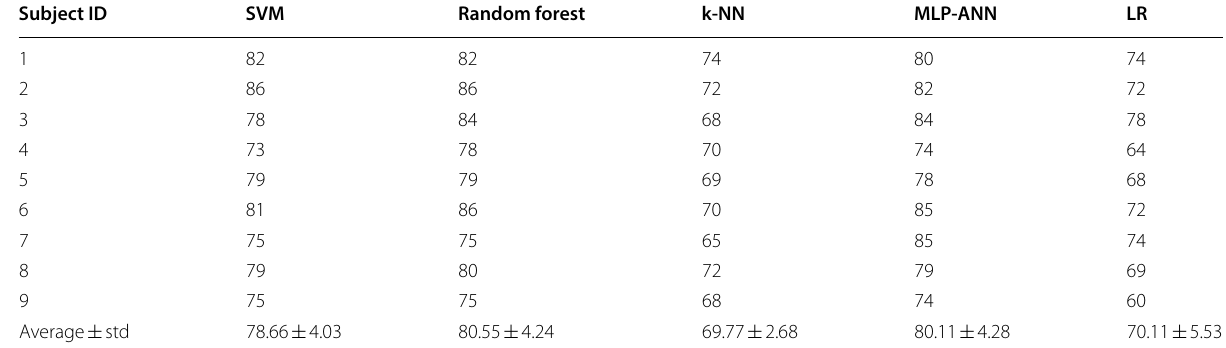
Table 2 The classification accuracy of the different classifiers after adopting the proposed algorithm Subject ID SVM Random forest